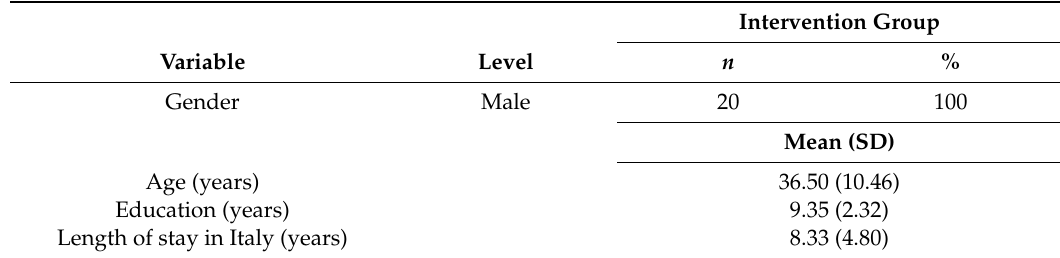
Table 2. Demographic characteristics of the migrant farmworkers trained with the new